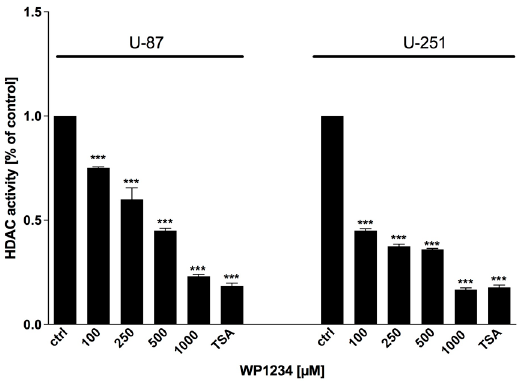
Figure 9. HDAC activity assay showing inhibitory effect of WP1234 (100–1000 µ M) treatment after 72 h. As a positive control of HDAC inhibition, Trichostatin A (TSA) was used. Significant differences between the treatment means and control (untreated cells) value are indicated by * p < 0.05, ** p < 0.01, *** p < 0.001.